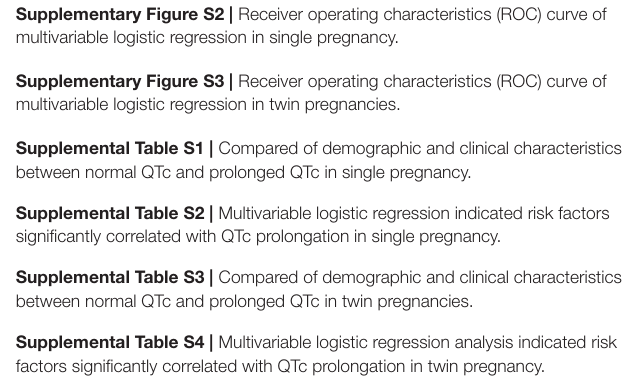
Supplementary Figure S2 | Receiver operating characteristics (ROC) curve of multivariable logistic regression in single pregnancy. Supplementary Figure S3 | Receiver operating characteristics (ROC) curve of multivariable logistic regression in twin pregnancies. Supplemental Table S1 | Compared of demographic and clinical characteristics between normal QTc and prolonged QTc in single